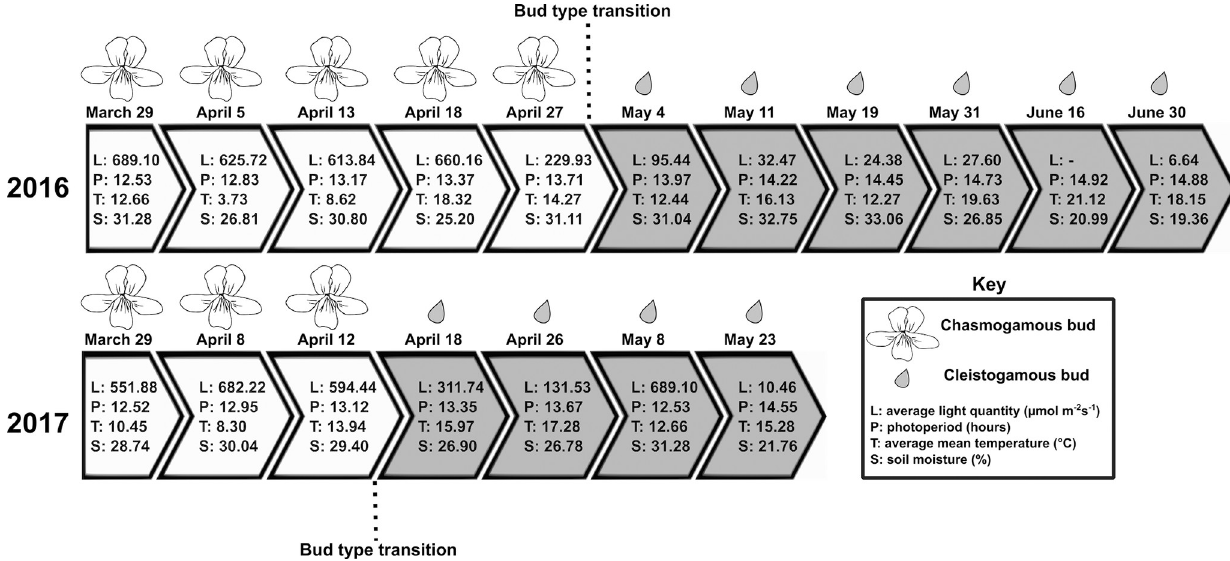
Fig 7. Schematic of measurement days in 2016 and 2017 with corresponding bud types and environmental values that occurred at each date. White arrows denote dates with chasmogamous buds and gray arrows are dates that cleistogamous budding was observed. L = average light quantity ( μ mol m -2 s -1 ), P = photoperiod (hours), T = average mean temperature (˚C), and S = average soil moisture